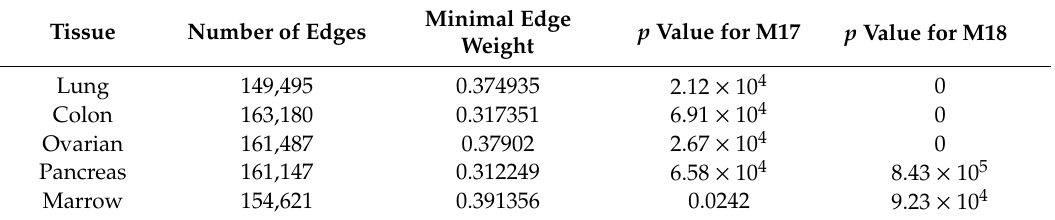
Table 8. Significance of target modules for TSA in five other TSA-related PPI